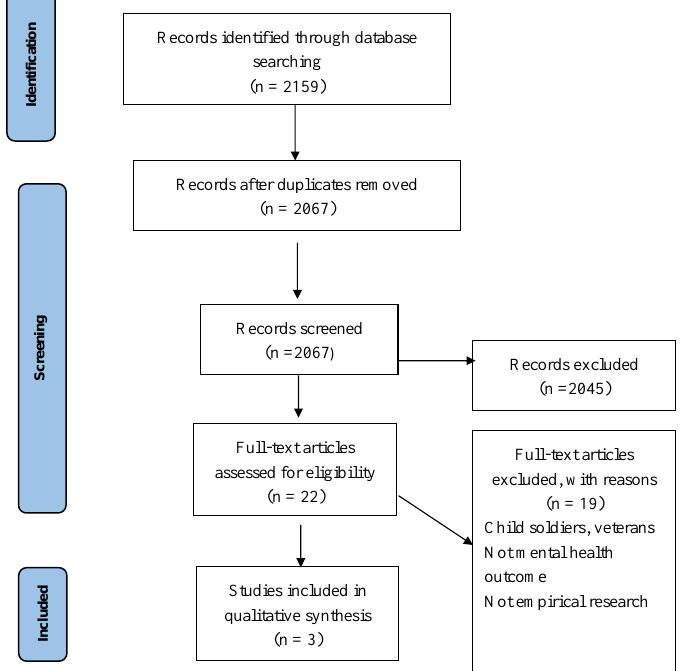
Figure 1. PRISMA flowchart- screening processes for narrative synthesis. 3. Results The PRISMA flowchart screening processes for narrative synthesis is shown in Figure 1.